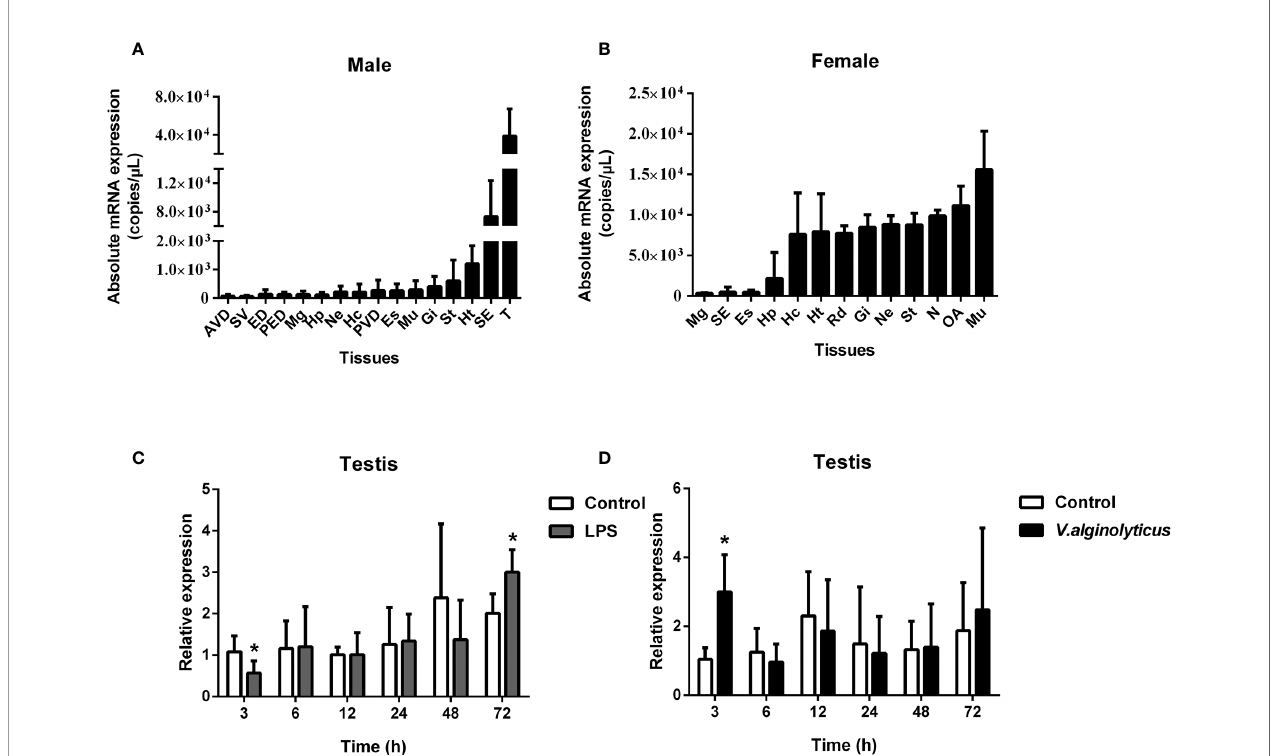
FIGURE 3 | Expression pro fi les of SpCTL6 gene in S. paramamosain adult. Tissue distribution of SpCTL6 in male (A) and female (B) crabs (n=5). The expression pattern of SpCTL6 in male testis after LPS (C) and V. alginolyticus (D) challenges (n=5). Signi fi cant difference was indicated by asterisks as * p < 0.05. AVD, anterior vas deferens; SV, seminal vesicle; ED, ejaculatory duct; PED, posterior ejaculatory duct; Mg, midgut; Hp, hepatopancreas; Ne, thoracic ganglion; Hc, hemocytes; PVD, posterior vas deferens; Es, eye stalk; Mu, muscle; Gi, gills; St, stomach; Ht, heart; SE, subcuticular; T, testis; RD, reproductive duct; N: spermathecae; OA,